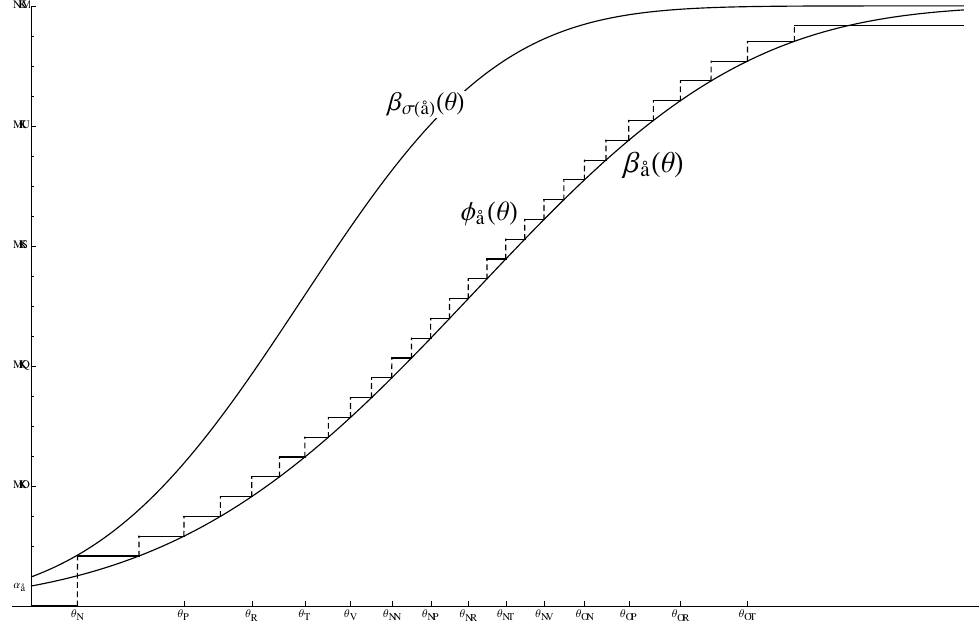
Figure A1. The basic idea of the proof is encapsulated in the figure. For any sample size n , we construct a step function φ n that “almost dominates” the power function β n . The step function dominates β n for all θ except those for which β n ( θ ) is less than α , or close to 1. Then, since the set of steps is finite, and the original test satisfies L IM C ON , there must be a sample size σ ( n ) such that the power function β σ ( n ) strictly dominates the step function. Since β σ ( n ) dominates the step function, β σ ( n ) ( θ ) can only be less than β n ( θ ) if β n ( θ ) is less than α , or they are both close to 1. The loss of power from n to σ ( n ) is thereby bounded by α . Iterating this process we get a sequence of “good” sample sizes n , σ ( n ) , σ 2 ( n ) , . . . such that the power is “almost increasing”. It remains only to interpolate the intermediate sample sizes with tests that throw out samples until they arrive at the nearest “good” sample